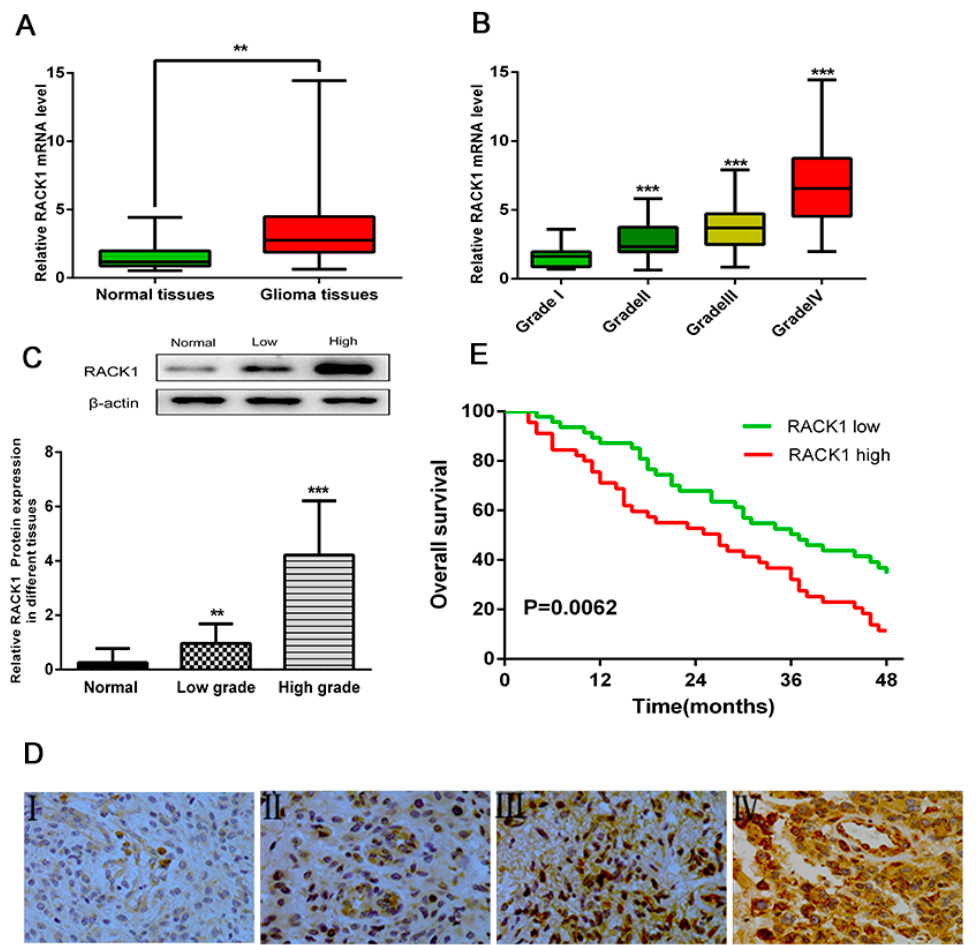
Figure 1. Overexpression of RACK1 was correlated with histological malignancy and poor clinical outcome in human gliomas. ( A ) The mRNA expression levels of RACK1 in glioma and normal brain tissues were detected by RT-PCR assays (** p < 0.01); ( B ) RACK1 mRNA expression levels in different glioma tissues (*** p < 0.001, *** p < 0.001, *** p < 0.001 as compared with grade I glioma tissues); ( C ) The protein levels of RACK1 in normal and glioma brain tissues (** p < 0.01, *** p < 0.001 as compared with normal brain tissues); ( D ) The expression of RACK1 was examined by immunohistochemistry staining in different grades of glioma tissues; ( E ) Kaplan-Meier analysis was performed to investigate the association of RACK1 expression level with the overall survival (OS) time in 92 cases of glioma patients ( p = 0.0062). (** p < 0.01, *** p < 0.001).